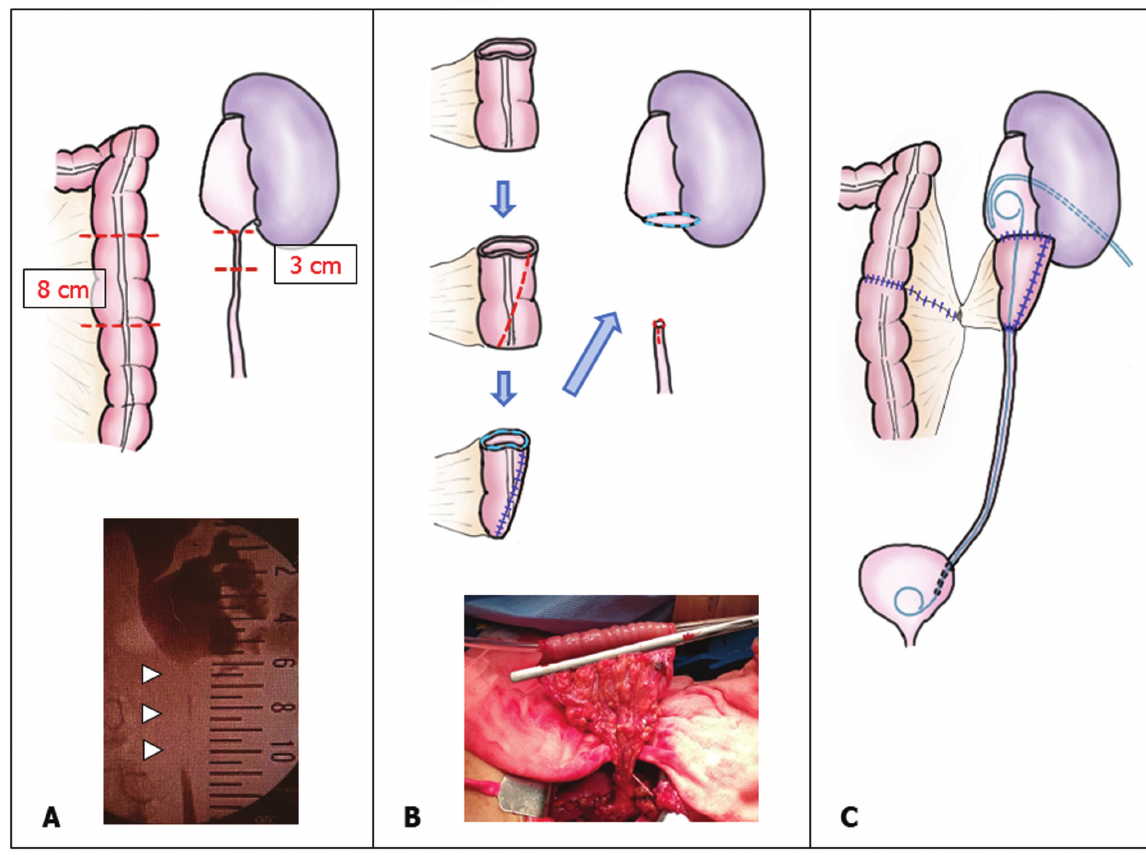
Fig. 1 Upper ureteral reconstruction with a tapered segment of descending colon. ( A ) Preoperative retrograde pyelography revealed a 5-cm- long stenosis of the ureter ( white arrowheads ). ( B ) An 8-cm-long descending colon ( A ) was isolated, tapered ( red dotted line ), sutured in a funnel shape, and then anastomosed to reconstruct the upper ureter. The photograph shows the colon segment being grasped before being tapered and sutured using a catheter as a temporary stent. ( C ) The fi nal outcome with a double J stent, percutaneous nephrostomy tube, and retroperitoneal